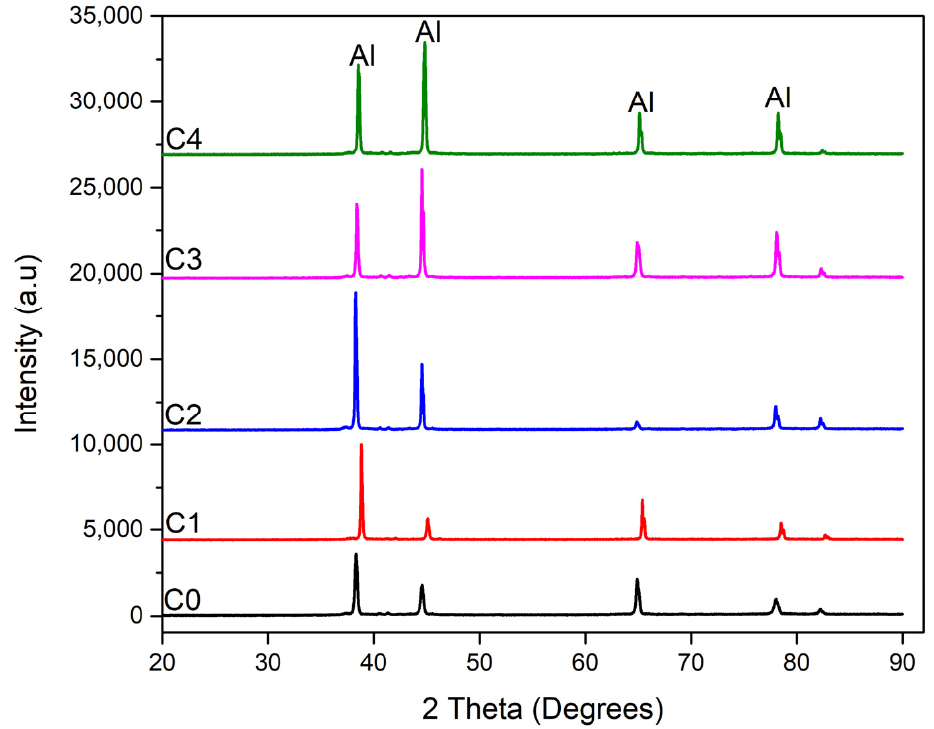
Figure 3. X-ray diffraction analysis of the base metal and AMCs.